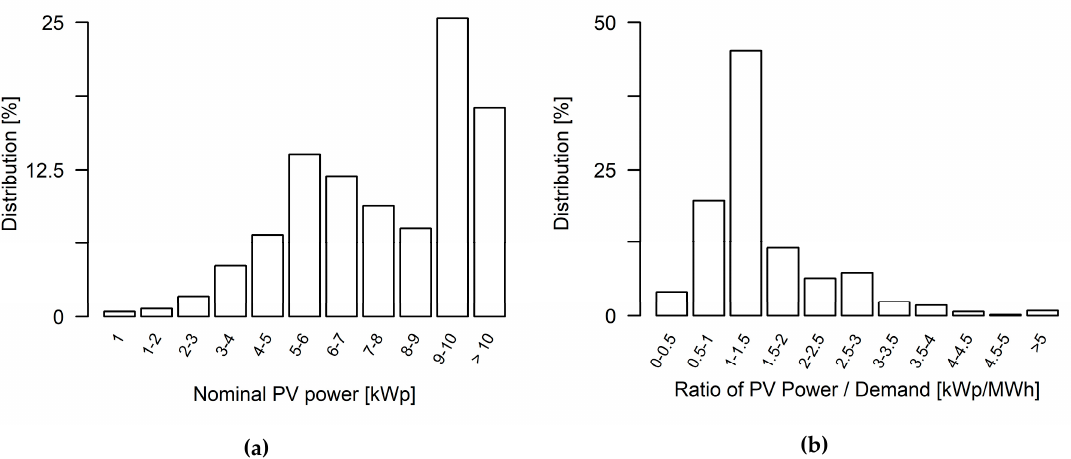
Figure 3. ( a ) Distribution of the nominal PV power dimensioned according to the current German distribution considering the technical constraints of the buildings; ( b ) distribution of the ratios between nominal PV power and annual demand (right side).